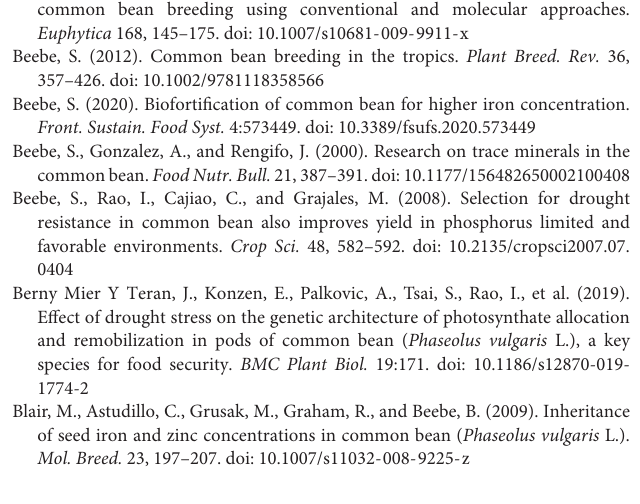
Supplementary Figure 1 | Precipitation, maximum, and minimum temperatures during trials at Palmira, Colombia. Supplementary Figure 2 | Histograms of frequency distribution for Fe and Zn in seven trials of the SCR16 × SMC40, SMC33 × SCR16, and SMC44 × SCR9 populations. Supplementary Figure 3 | Genome-wide association analysis for Fe accumulation (SdFe) showing Manhattan and Q-Q plot for SMC × SCR populations with 24,785 markers in seven trials. The Bonferroni correction threshold ( p = 0.05) is presented as a red horizontal line based on the number of markers for the population. Supplementary Figure 4 | Genome-wide association analysis for Zn accumulation (SdZn) showing Manhattan and Q-Q plot for SMC × SCR populations with 24,785 markers in seven trials. The Bonferroni correction threshold ( p = 0.05) is presented as a red horizontal line based on the number of markers for the population. Supplementary Figure 5 | Heterozygosity of individuals and heterozygosity of markers in the SMC × SCR populations. Supplementary Table 1 | Phenotypic variability and broad-sense heritability (H 2 ) for evaluated traits in the trials 2011, 2012, 2013, 2014, and 2015 of the SCR16 × SMC40, SMC33 × SCR16, and SMC44 × SCR9 populations. Supplementary Table 2 | Component variance, F statistic evaluated for seven trials to SdFe, seed iron; SdZn, seed zinc; PHI, pod harvest index; PdN, pod number; SdN, seed number; Sd/Pd, number of seeds per pod; 100SdW, 100 seed weight in SCR16 × SMC40, SMC33 × SCR16, and SMC44 × SCR9 populations. Supplementary Table 3 | Pearson’s correlations coefficients between evaluated traits on three populations SCR16 × SMC40, SMC33 × SCR16, and SMC44 × SCR9 for each trial and each trait. Significance of correlations indicated as ∗∗∗ p < 0.0001; ∗∗ p < 0.001; ∗ p < 0.01; ns, not significant. SdFe, seed iron; SdZn, seed zinc; PHI, pod harvest index; PdN, pod number; SdN, seed number; Sd/Pd, number of seeds per pod; 100SdW, 100 seed weight. Supplementary Table 4 | Details of all QTL identified by inclusive composite interval mapping for additive effects (ICIM-ADD), genetic and physical position, LOD, phenotypic variation explained mapped for six traits in SCR16 × SMC40, SMC33 × SCR16, and SMC44 × SCR9 populations evaluated in 2011, 2012, 2013, 2014, and